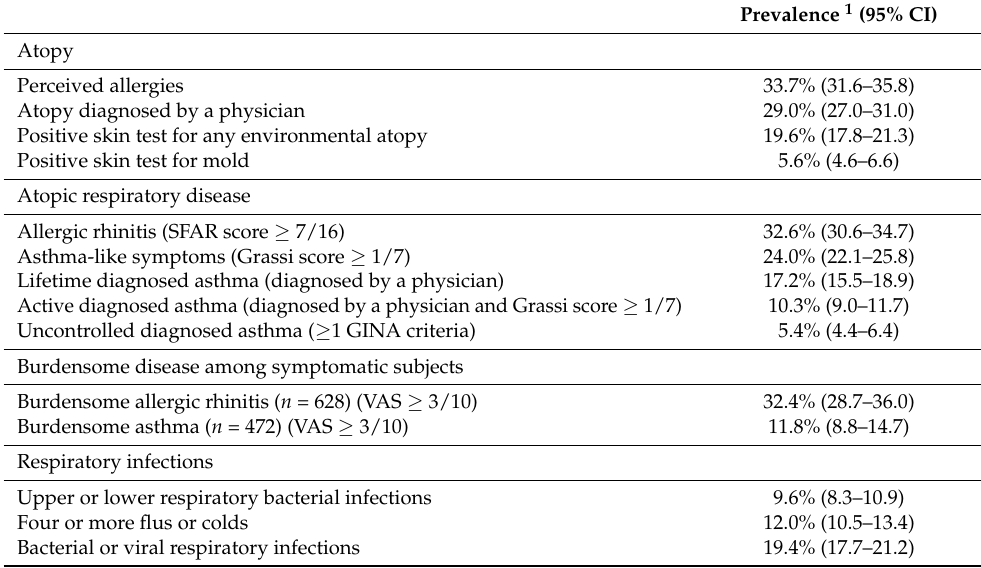
Table 1. Global prevalence of self-reported atopy and respiratory disease (in the last 12 months) among university students (weighted data, n =